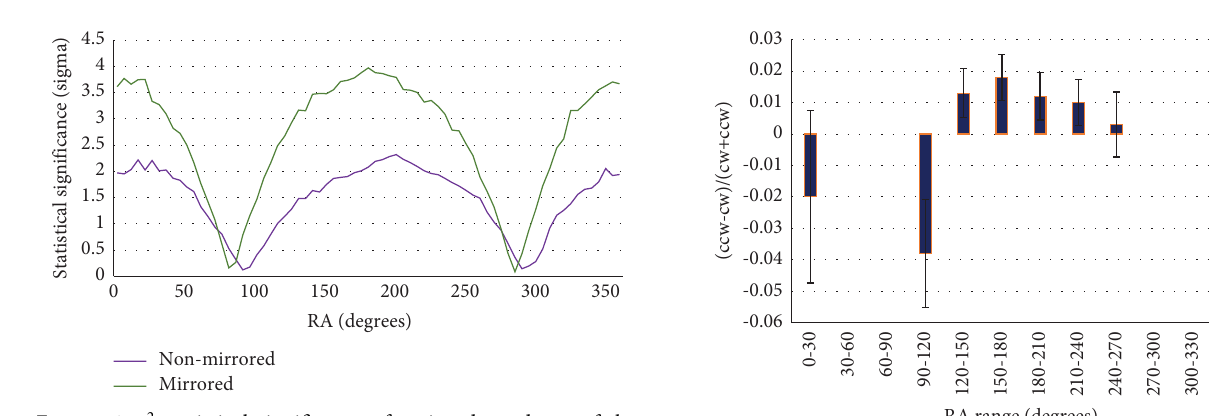
Figure 4: χ 2 statistical signifcance of cosine dependence of the galaxy spin directions from diferent RAs when the declination is 25 o . Te analysis was done with the original and mirrored galaxy images annotated by SpArcFiRe .